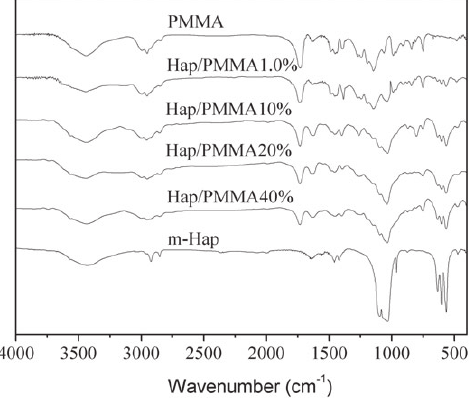
Figure 4 FTIR spectra of HAp/PMMA, HAp and PMMA. m-HAp is abbreviated as HAp for the names of nanocomposites in the